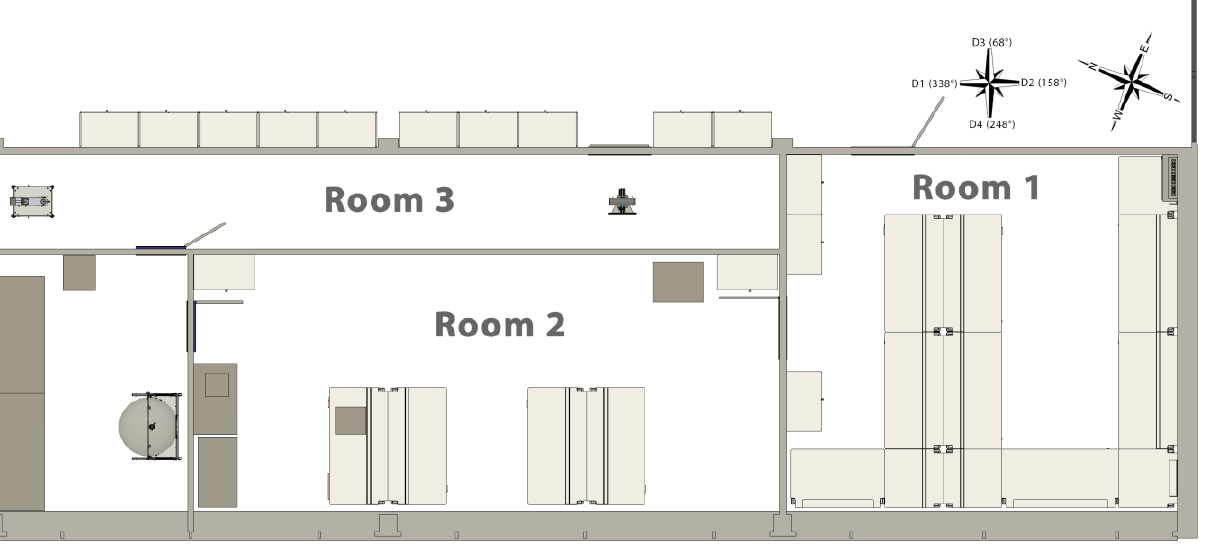
Figure A4. Top view of the three studied rooms with the definition of directions D1 – D4. Table A1. Height above the floor for the spectrum test points in the three rooms (R1 to R3). Height (cm) Room